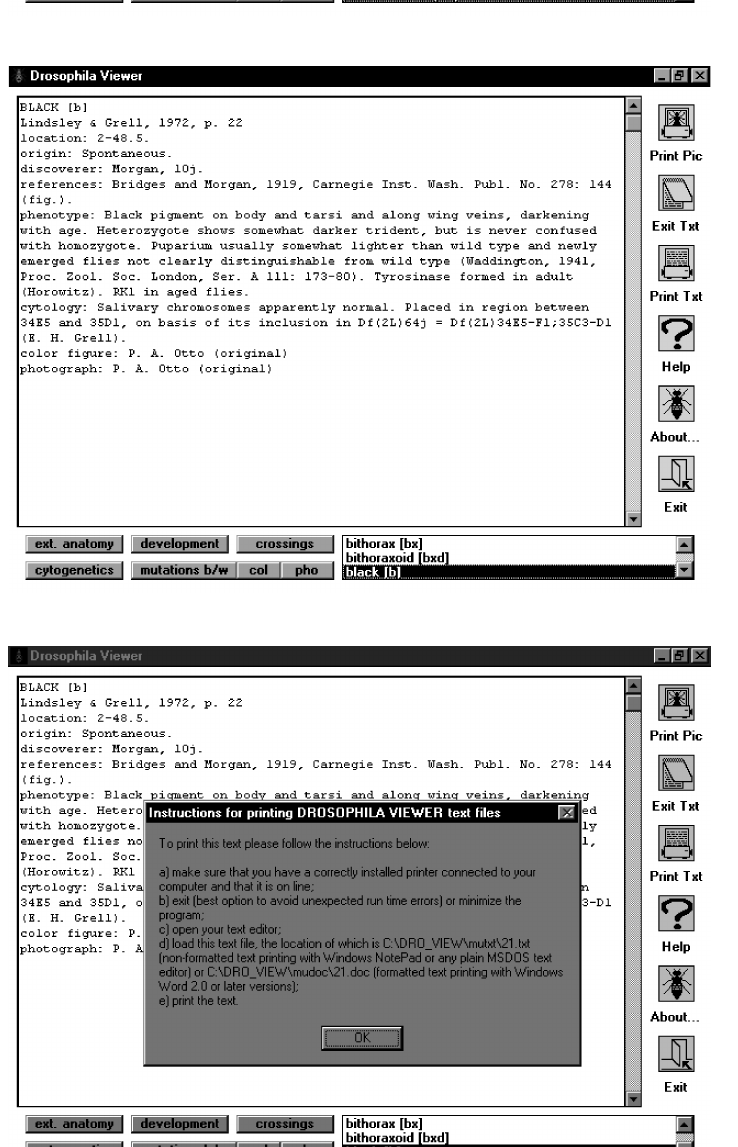
Figure 10 - Color photomicrograph of whole-mounted prepara- tion of a fly presenting the X-linked recessive mutation cross- veinless (original photo and preparation). The picture was se- lected by clicking the item in the option list shown on the right after pressing the command button “(mutations) pho(to).”